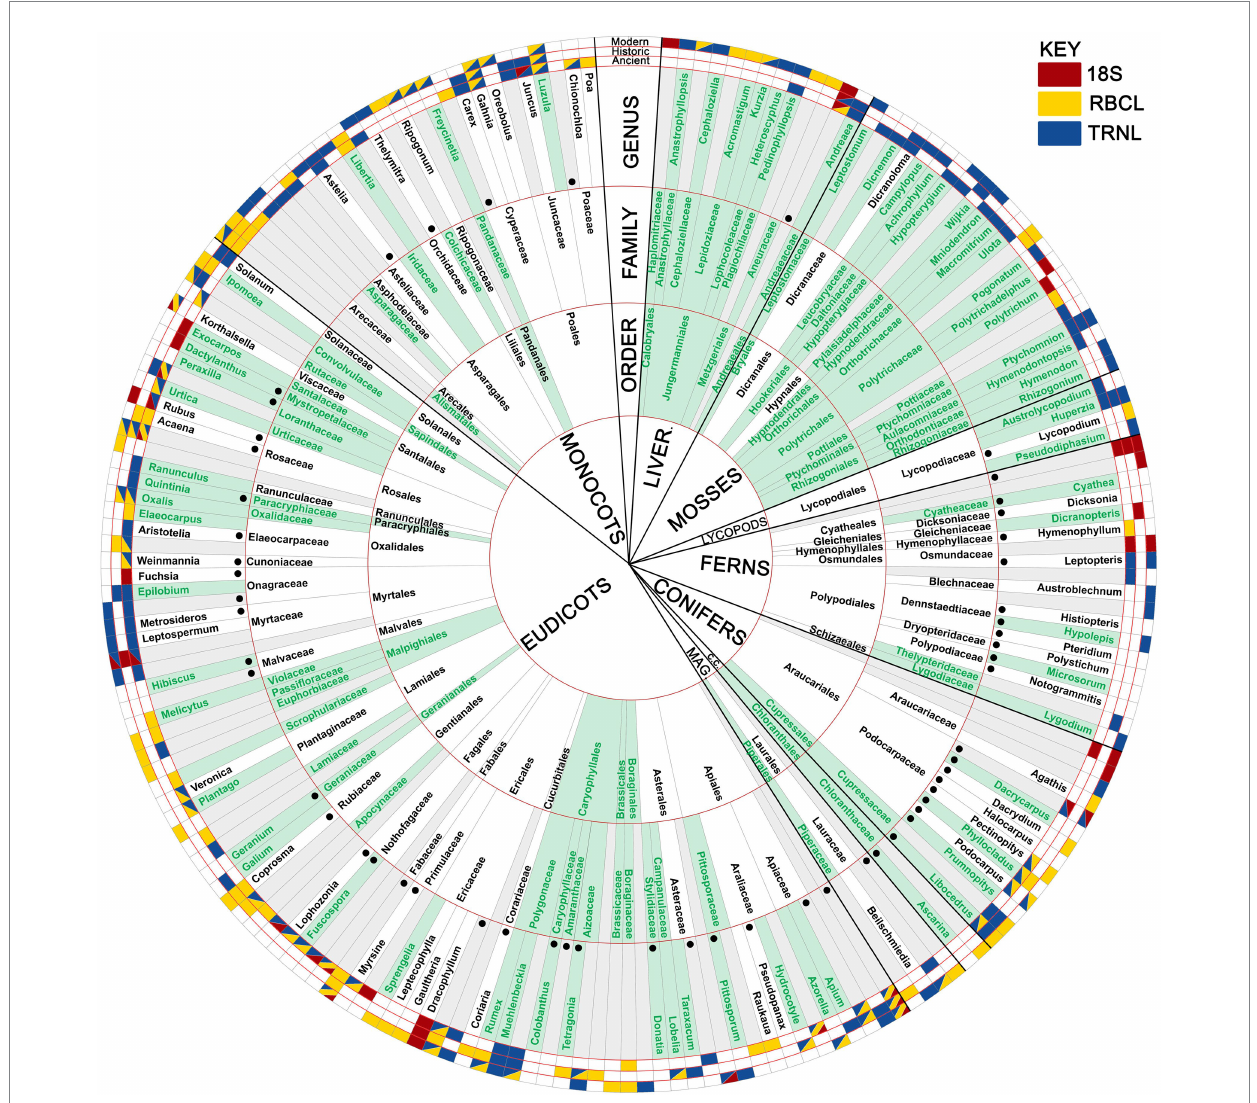
FIGURE 4 Chart showing all native taxa found in this study. Novel taxa (taxa not recovered from observation-based studies of kakapo post c. 1950), are coloured green. Outer cells (representing presence/absence) are subdivided by age group and coloured by gene. Black circles denote the presence of palynomorphs (ancient samples only). Grey cells represent sequences/palynomorphs not identified to the designating rank. Main ranks not shown in full: MAG (Magnoliidae), C.C. (Chloranthales